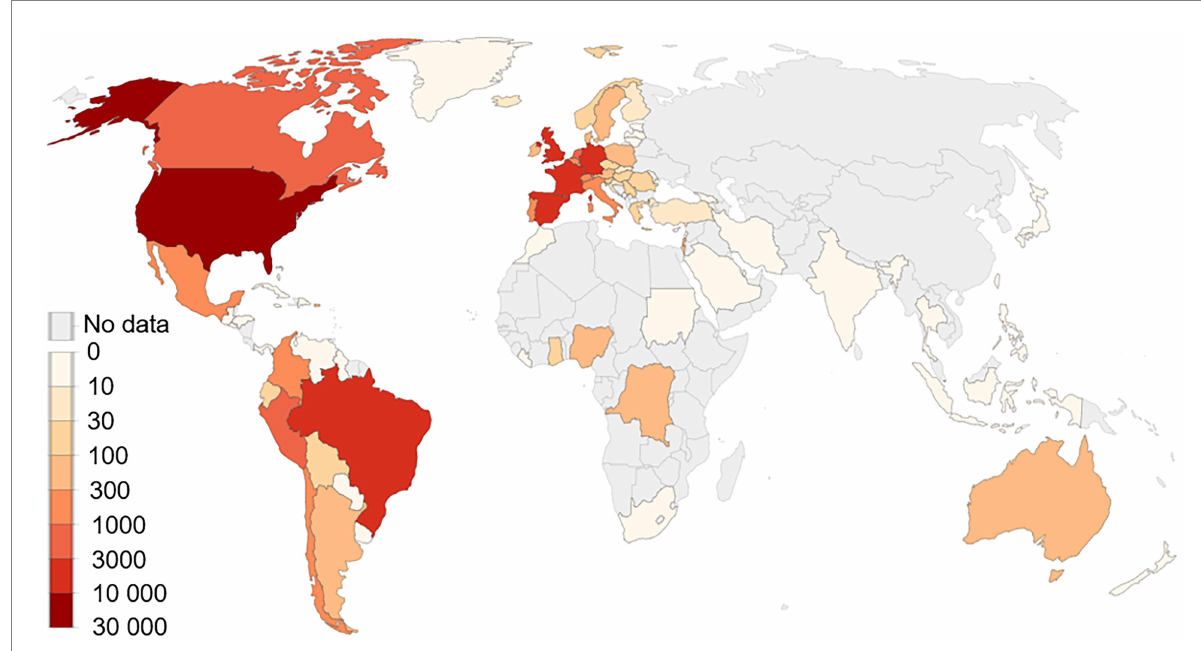
FIGURE 1 Global map of cumulative confirmed cases in endemic and non-endemic